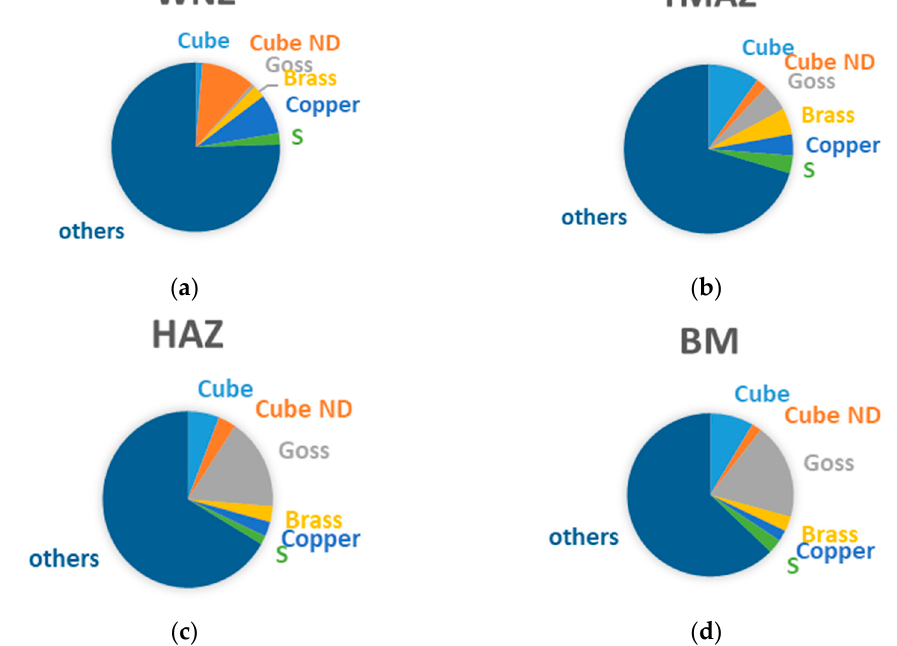
Figure 5. Texture distribution in the ( a ) WNZ, ( b ) TMAZ, ( c ) HAZ, and ( d ) BM of the joint.